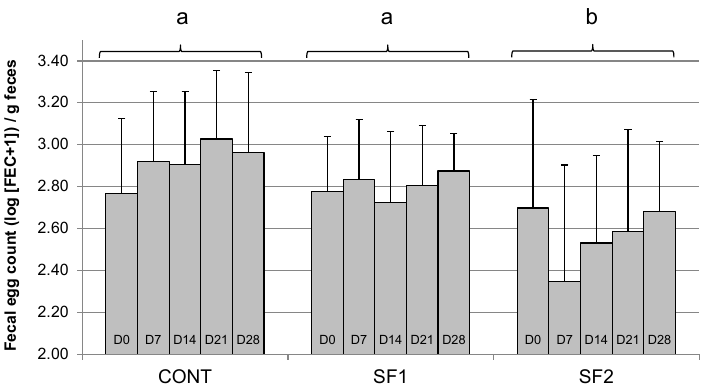
Figure 1. Changes in mean fecal egg count (log-transformed FEC) in naturally infected horses fed a control diet (CONT), a diet providing 1.53 g (SF1) or 3.06 g (SF2) DM pelleted sainfoin/kg BW/day from D1 to D28 during the pre-anthelmintic treatment period. Mean values ± SD are reported. a, b: different letters indicate significant differences between diets. Plotting temporal changes in FEC for each individual horse showed substantial inter- individual variation (Figure 2). Using coefficients of variation of FEC as the dependent variables showed that, when receiving the diet with the highest sainfoin contents (SF2), inter-individual variation increased compared to the other experimental groups (mean ± SD: SF2, 0.18 ± 0.04; CONT, 0.12 ± 0.01; SF1, 0.10 ± 0.02) ( p = 0.003). CV did not vary throughout the time (Day, p = 0.36).